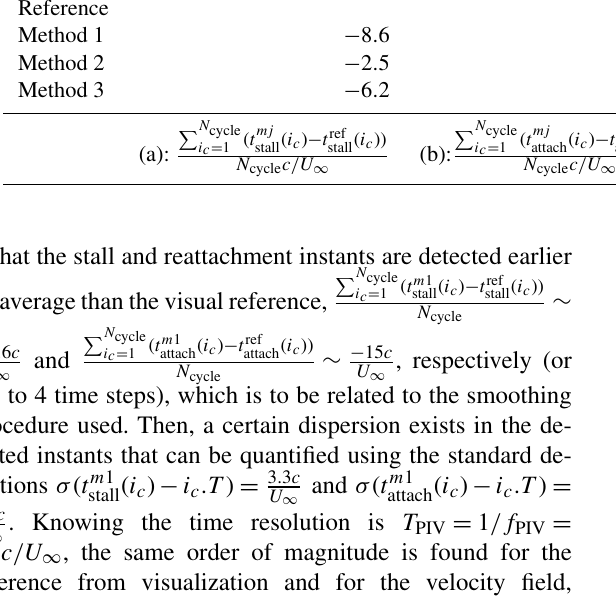
,i = 1 , 2, of the first three modes respec- Figure 11. POD decomposition. Panels (a) , (b) and (c) represent the eigenvector vector field, (cid:57) n i tively ( n = 1 , 2 , 3) with isocontours of its modulus superimposed. The associated energy content of the n th mode (i.e. (cid:51) n ) is written in the title; (d) represents the corresponding temporal coefficients scaled with their energy content. Table 1. Summary of detected stall–reattachment instants using the three methods including the reference case. All times are expressed as chord times ( t c = c/U ∞ ). Means of delays of Means of delays of Standard deviation of Standard deviation of stall detection (a) reattachment detection